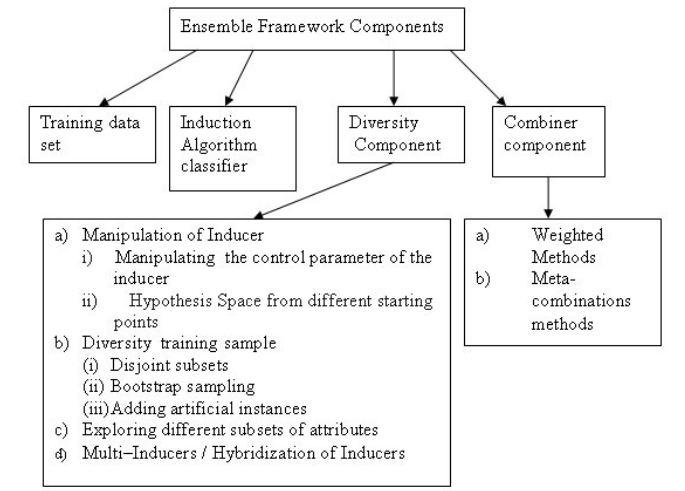
Figure 1. Ensemble framework